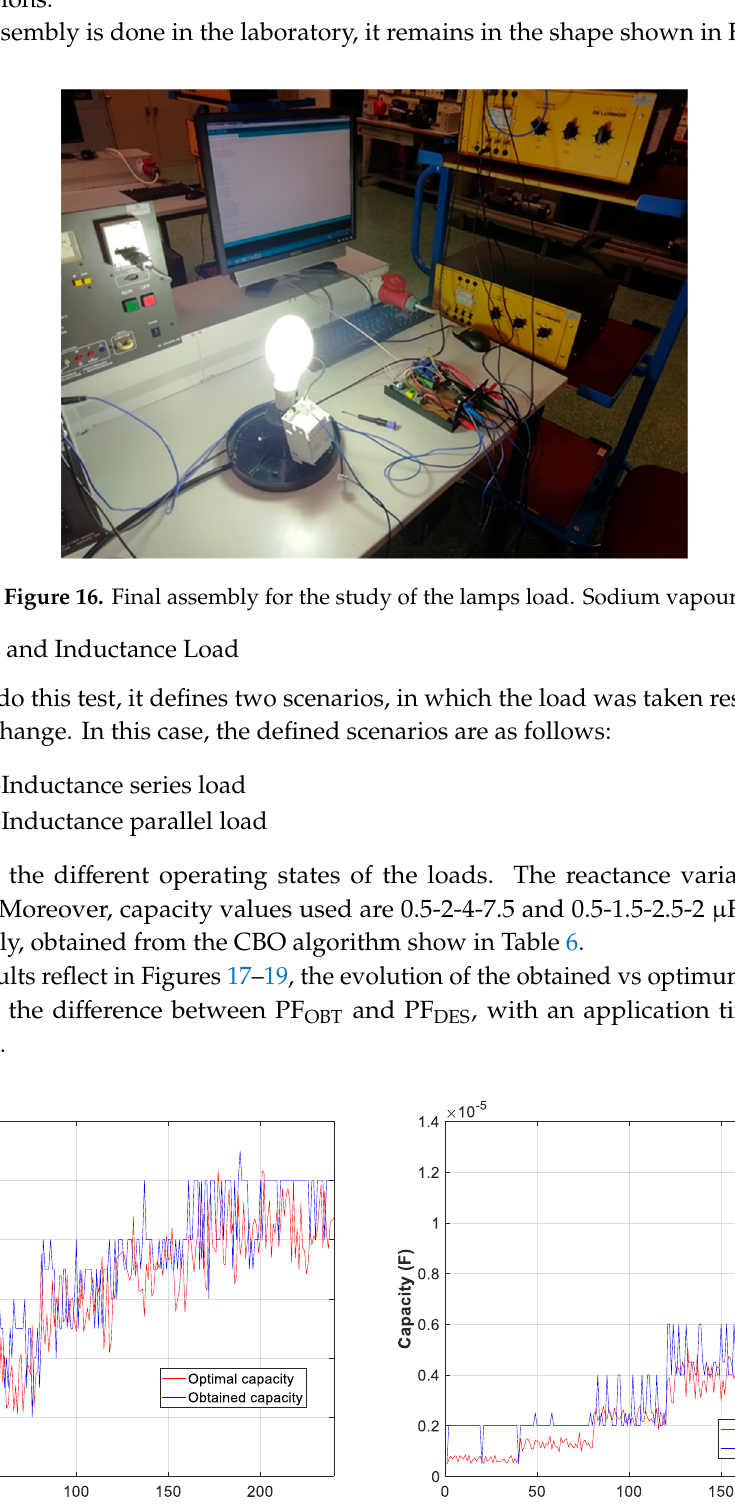
Figure 15. Difference between PF OBT and PF DES (Metal halide).